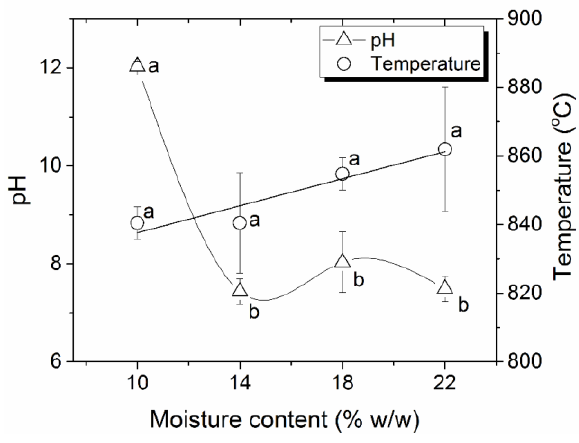
Figure 1. The pH and reaction temperature of biochar produced under varying biomass moisture contents (airflow 20 L/min, particle size 7 mm, and biomass compactness 0 kg). Different letters represent significant different level at 10%.